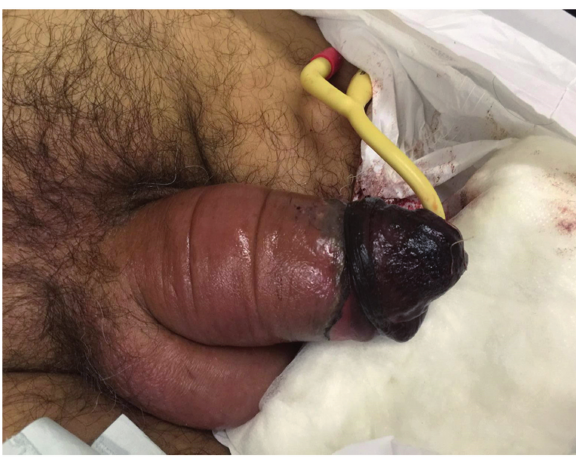
Figure 2 - Patient with penile incarceration produced by a plastic ring with signs of tissue impairment of the distal penile